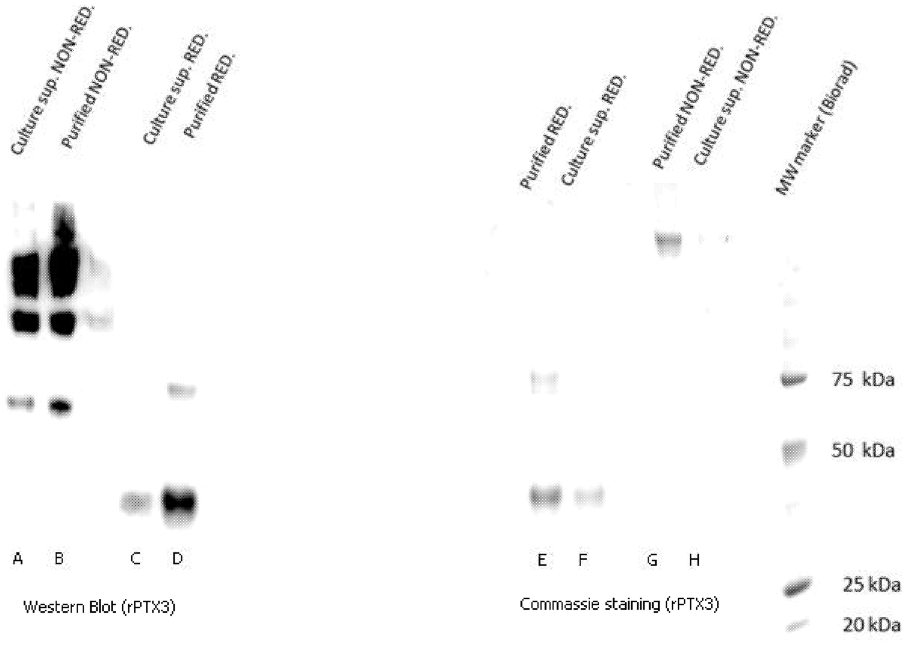
Figure 1. Western blot (left) and Commassie staining (right) of recombinant PTX3 are shown. Lanes A and B show the culture supernatant (A) and purified protein (B) under non-reducing conditions: step ladder formation reflecting the equilibrium between the different PTX3 oligomers. Lanes C, D, E and F show the culture supernatant (C, F) and the purified protein (D, E) under reducing conditions: PTX3 monomer at 45 kDa. Lanes G and H show the purified protein (G) and the culture supernatant (H) under non-reducing conditions: the predominantly multimer of PTX3 with a MW of 340 kDa. The rightmost lane provides the standard for molecular weight ranging from 10–250 kDa.